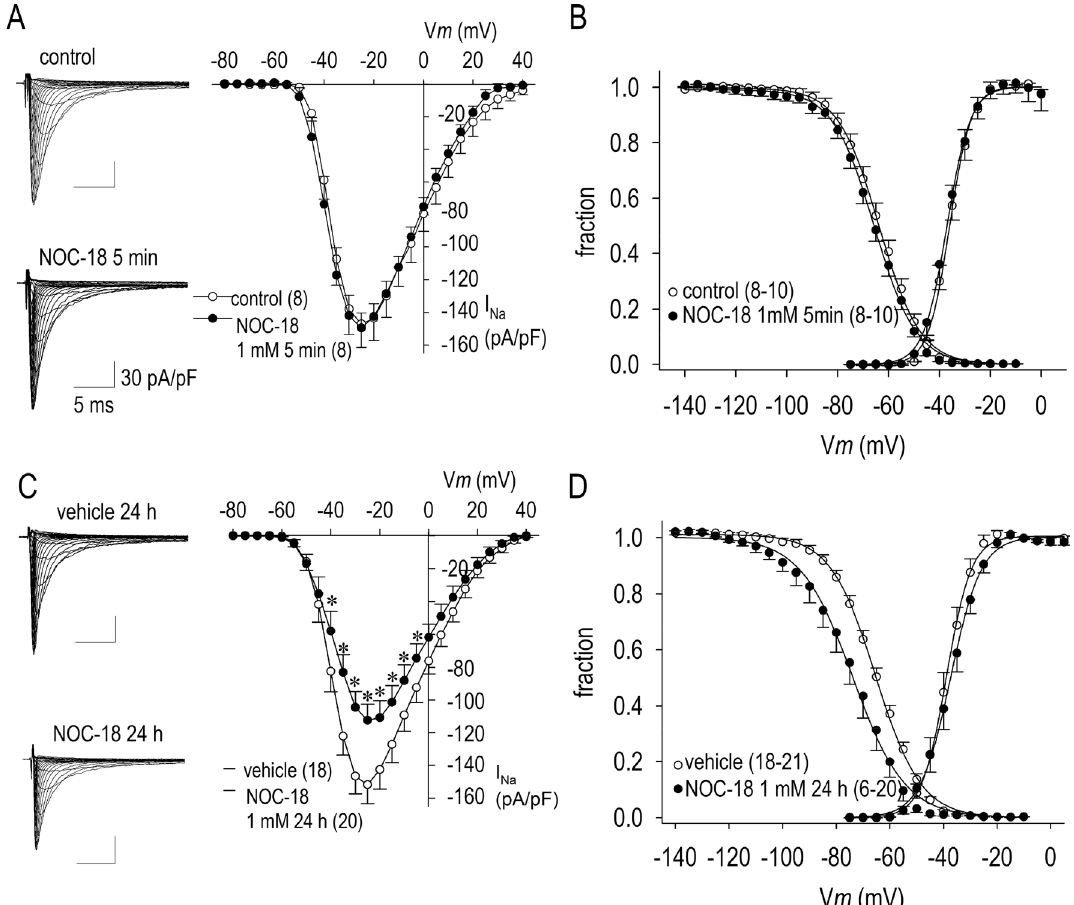
Figure 1. Short- and long-term effects of NOC-18 on Na + channel current (I Na ) in neonatal rat cardiomyocytes. ( A ) Representative I Na traces in the control condition and during the acute (5 min) application of 1 mM NOC-18 given to the same patch are shown. I Na was recorded by a depolarization pulse of 50 ms duration, ranging from − 80 to 40 mV in 5 mV steps, applied from holding potentials of − 140 mV. Current (I)–voltage (V) relationship before (control) and after application of 1 mM NOC-18 (5 min) demonstrates the maximum inward current of the control (− 151.2 ± 14.9 pA/pF) and with NOC-18 (− 156.2 ± 9.5 pA/pF). ( B ) The steady-state inactivation and activation (conductance) curves of the control and during application of NOC- 18 (5 min); Mid-points of the voltage relation for the activation ( V a,1/2 ) was − 36.0 ± 0.2 mV in the control and − 37.1 ± 0.2 mV during application of NOC-18; Midpoint of the voltage relation for the inactivation ( V i,1/2 ) was − 63.7 ± 0.2 mV in the control and − 65.6 ± 0.2 mV during application of NOC-18. ( C ) Representative I Na traces with vehicle or NOC-18 treated for 24 h. I–V relationship demonstrates the maximum inward current of vehicle (− 160.7 ± 11.6 pA/pF, n = 18) and with NOC-18 (− 122.2 ± 10.9 pA/pF). ( D ) The steady-state inactivation and activation (conductance) curves of vehicle (24 h) and NOC-18 (24 h); V a,1/2 was − 39.0 ± 0.2 mV in vehicle and − 37.4 ± 0.2 mV in NOC-18 (24 h); V i,1/2 was − 65.3 ± 0.2 mV in vehicle and − 73.8 ± 0.4 mV in NOC-18 (24 h). Values represent the mean ± SE. Numbers of cell are shown in parentheses. * p < 0.05 vs.